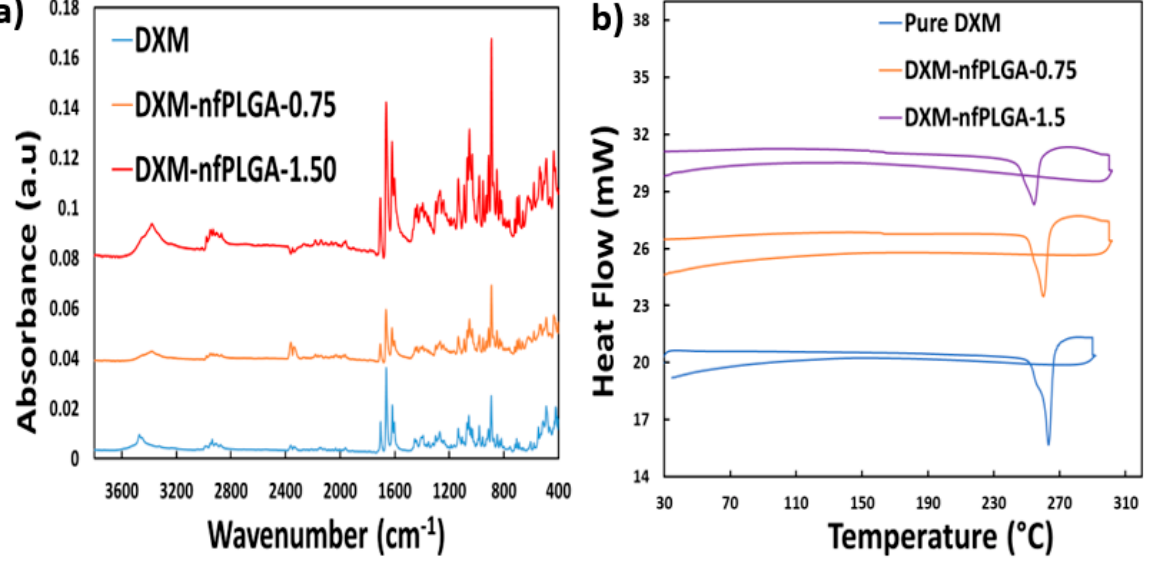
Figure 6. ( a ) DXM– nf PLGA composites FTIR and ( b ) DXM– nf PLGA composites DSC analysis.